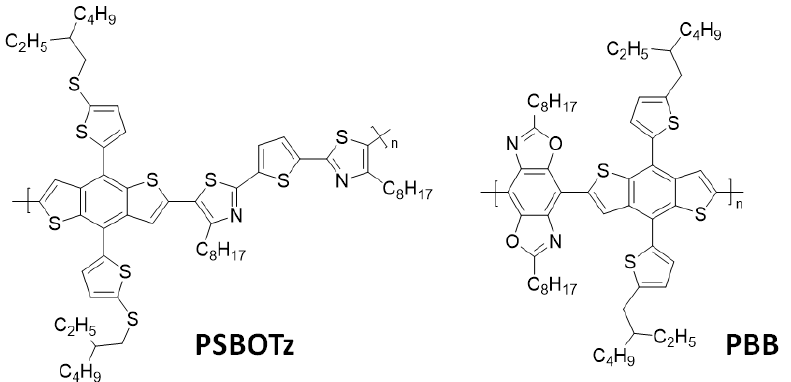
Figure 1. ( a ) UV-Vis absorption spectrum of the CPs in solution and in the film state. ( b ) CV plots of the study materials in the film state, and ( c ) energy diagrams extracted from the CV